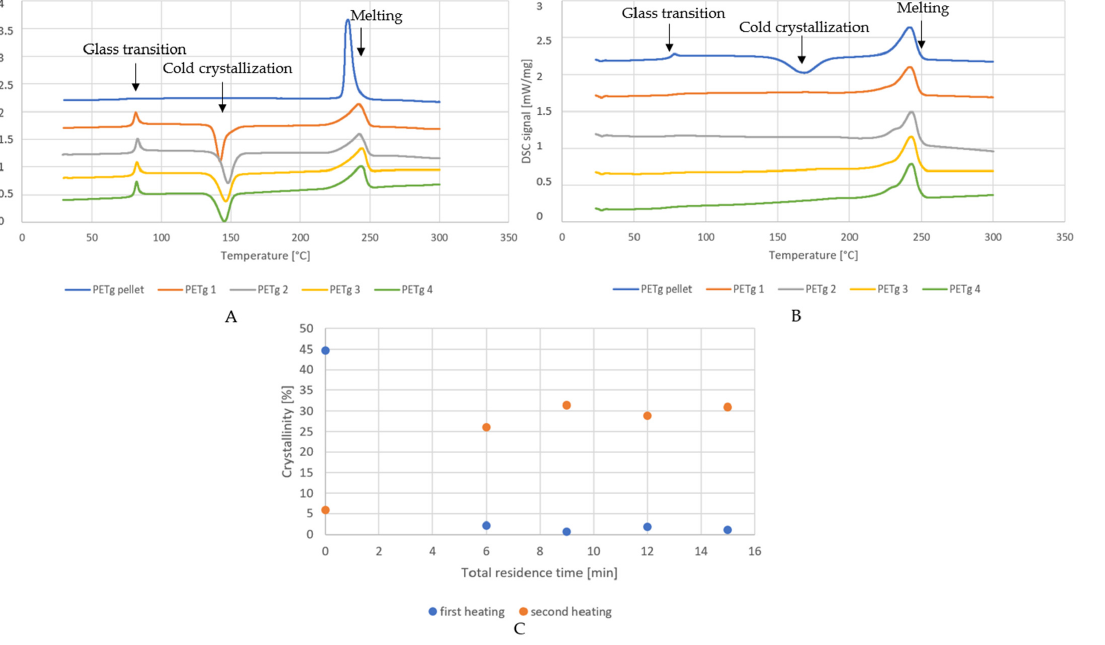
Figure 4. DSC curves of the first ( A ) and second ( B ) heating run of the PETg samples. Crystallinity of the PETg residence time samples vs. total residence time ( C ) (Table 1).